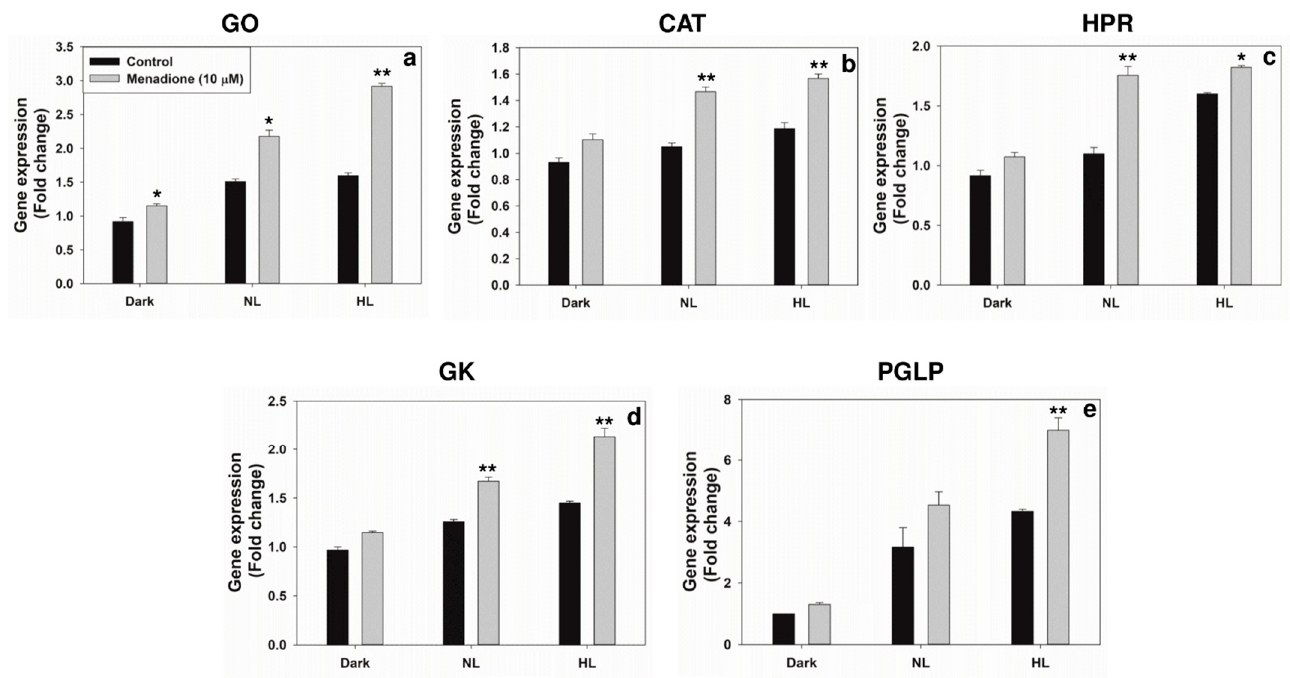
Figure 5. The transcript levels of glycolate oxidase (GO) ( a ), catalase (CAT) ( b ), hydroxypyruvate reductase (HPR) ( c ), glycerate kinase (GK), ( d ), and phosphoglycolate phosphatase (PGLP) ( e ), in extracts from leaf discs on exposure to MD and/or high light (HL, 1200 µmol m − 2 s − 1 ). The expression of genes was represented as fold-change after normalization with actin 2. Each data point is the average of three replicates, and error bars represent ±SE. Asterisks indicate the significance of MD effect compared to the respective control. * p < 0.05 ; ** p < 0.001.